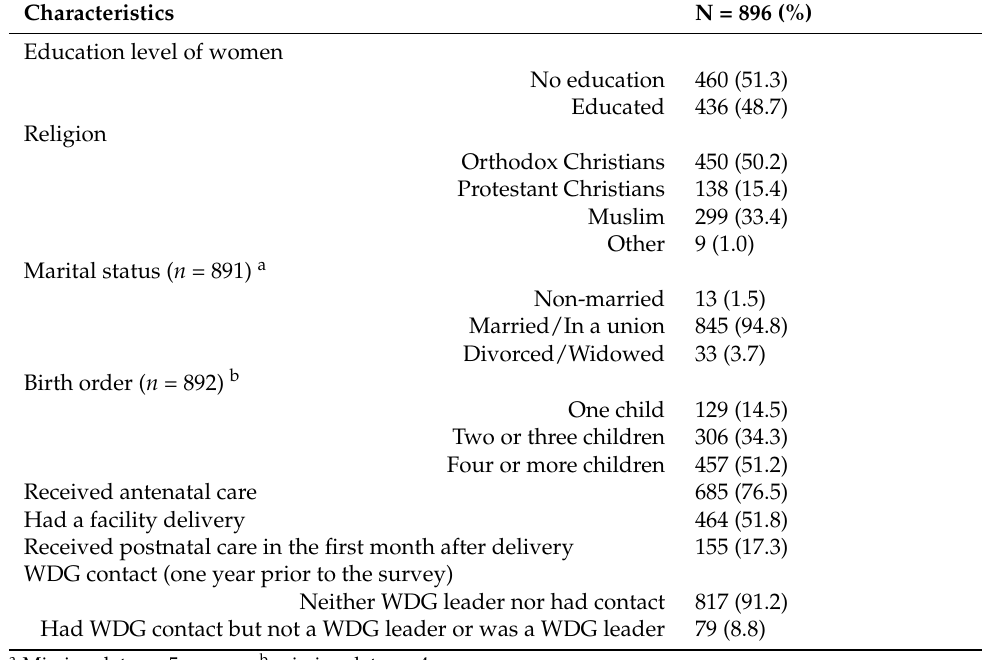
Table 1. Characteristics of women who delivered in the 12 months prior to the study in Ethiopia,